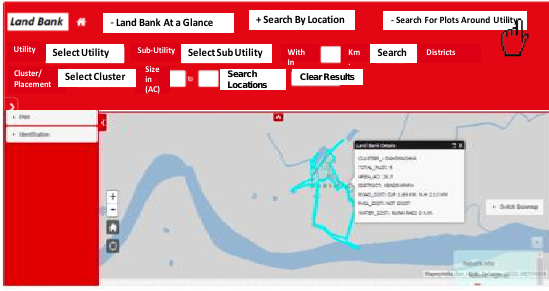
Figure 7. Land Bank Search Module to provide plots around selected utilities